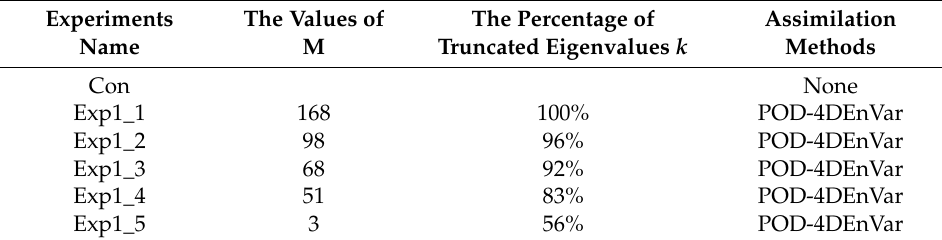
Table 5. Experimental design for eigenvector truncation sensitivity.